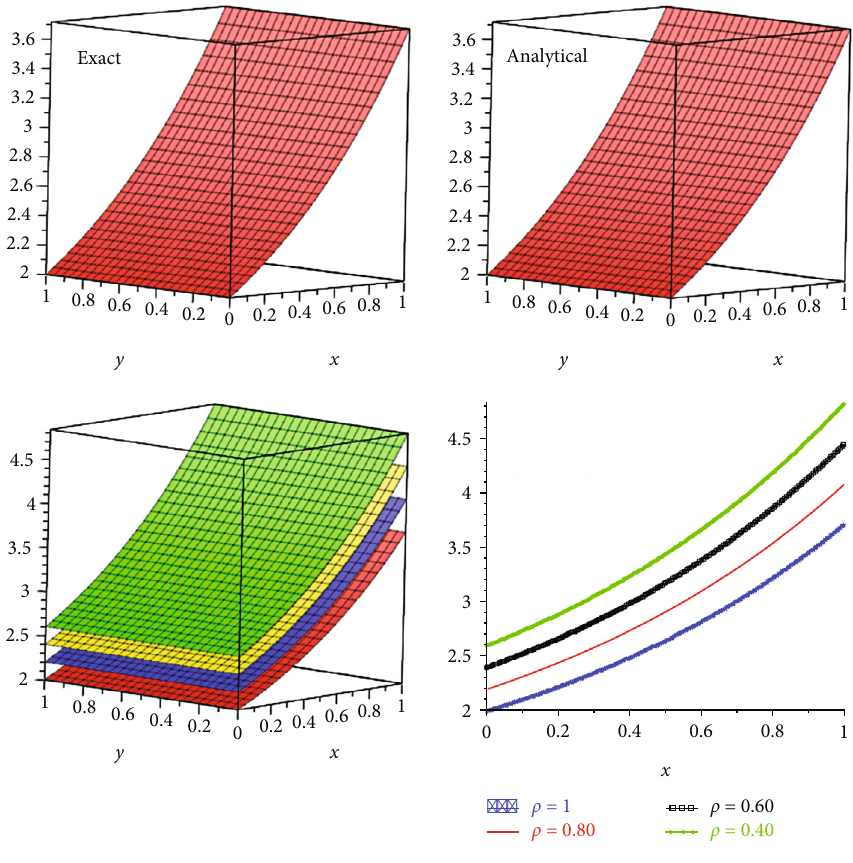
Figure 2: The graphical layout for problem Table 2: Comparison of the exact and suggested method solution with the aid of absolute errors for problem 2. ϑ = 0 : 01 Exact solution